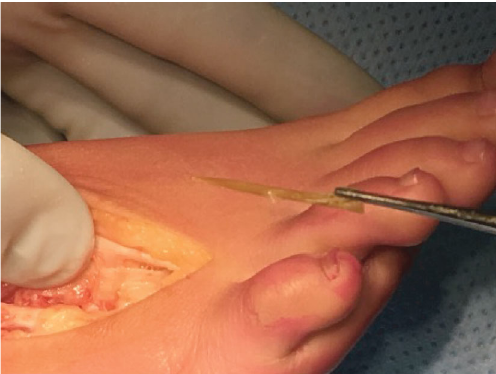
Figure 2: Peroperative taken clinical picture, with the completely removed wooden foreign